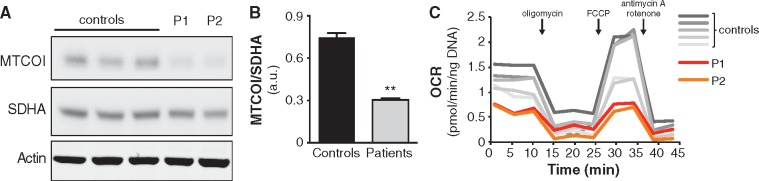
Cells from PS patients show impaired mitochondrial function. (A) Western
blot from PS patient and control skin fibroblasts; both patients present with
decreased MT-CO1 protein levels, while SDHA levels are unaffected. P1: PS patient 1,
P2: PS patient 2. (B) Histogram depicting the MT-CO1 to SDHA ratio, as
quantified from a western blot with samples depicted in panel A, in biological
duplicates. Data are represented as the mean±SEM. **p<0.01 as calculated by a
2-tailed student’s t-test. (C) Seahorse respirometry on PS patient and
control skin fibroblasts; both PS patients have reduced basal and maximal respiration.
Injections of compounds during measurement are indicated with arrows. OCR: oxygen
consumption rate, P1: PS patient 1, P2: PS patient 2.